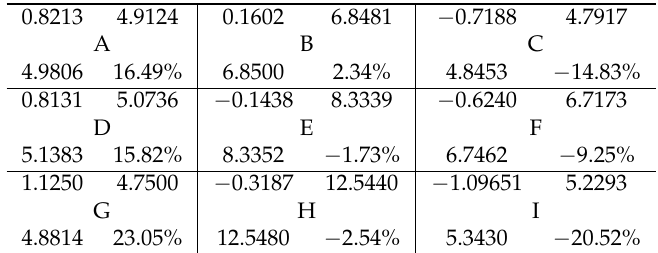
Table 1. Velocity components for dense initial packing density presented for nine zones, from A–I. Each quadrant presents Vx (V, velocity), Vy, Vt (t, total), or Vp (p, pointer), clockwise from the upper-left corner. Vx, Vy, and Vt are given in pxpf (pixels per frame).